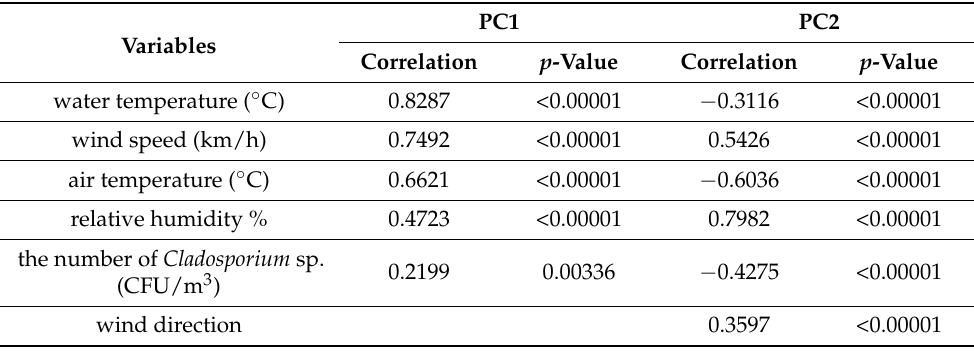
the number of Cladosporium sp. (CFU/m 3